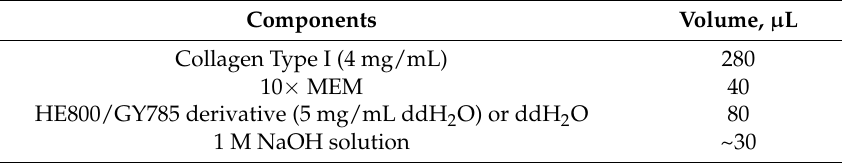
Table 2. The composition of the hydrogels produced. MEM–Minimum Essential Medium, ddH 2 O– double-deionized